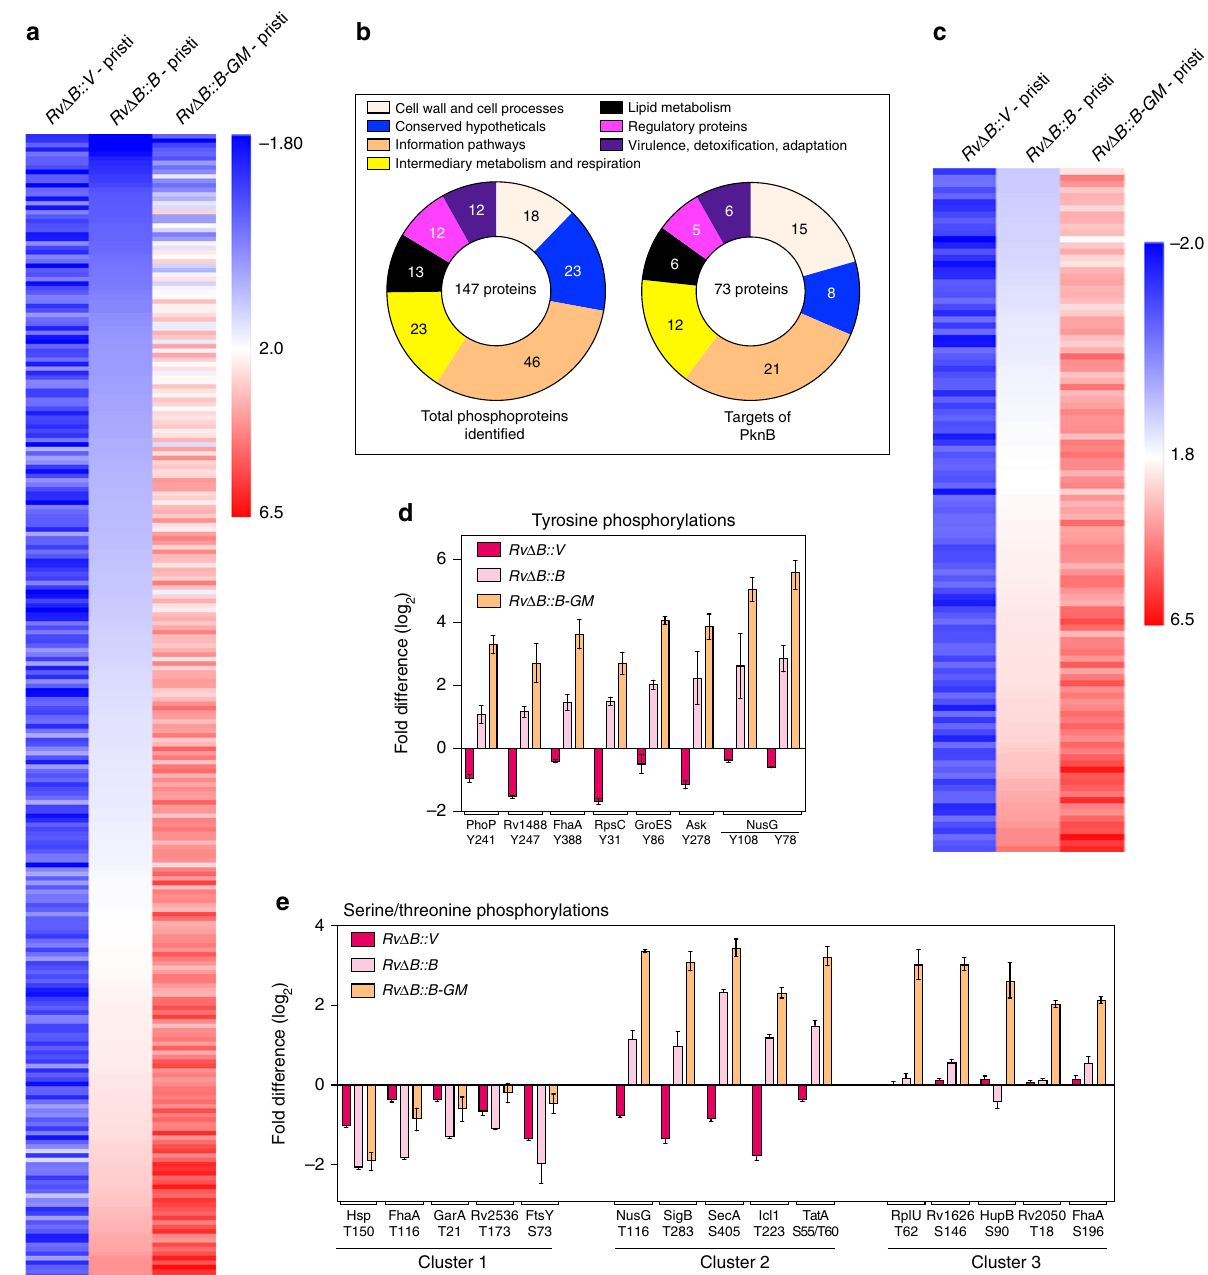
Fig. 7 Ligand binding mutation causes global hyperphosphorylation of speci fi c and non-speci fi c targets. a TMT intensities of phosphopetides in Rv Δ B - pristinamycin (PknB depleted sample, labeled with TMT 127) or in Rv Δ B::B (complemented with 3F-PknB, labeled with TMT 128) or Rv Δ B::B-GM (complemented with 3F-PknB-GM, labeled with TMT131), with respect to Rv Δ B + pristinamycin as the reference comparator (control strain, labeled with TMT 126). The intensities of phosphopeptides in each case were normalized with respect to the corresponding absolute protein intensities and the values were converted to log2 values. Data were sorted with respect to Rv Δ B::B sample and heatmap of the data were generated using online tool Morpheus. b The 257 phosphopeptides detected in TMT experiment belonged to 147 unique proteins, which were classi fi ed according to their functional category with reference to mycobrowser database. The phosphopeptides were categorized as probable PknB substrates if the TMT log 2 phosphointensity upon depletion was < − 0.32 and upon complementation was >1. 111 phosphopeptides were classi fi ed as probable PknB substrates, which belonged to 73 unique proteins. The 73 PknB targets were also functionally characterized according to mycobrowser database. c Normalized TMT intensities of all 111 phosphopeptides which are probable PknB targets were converted to log 2 values and data were sorted with respect to Rv Δ B::B . Heatmap was generated using online